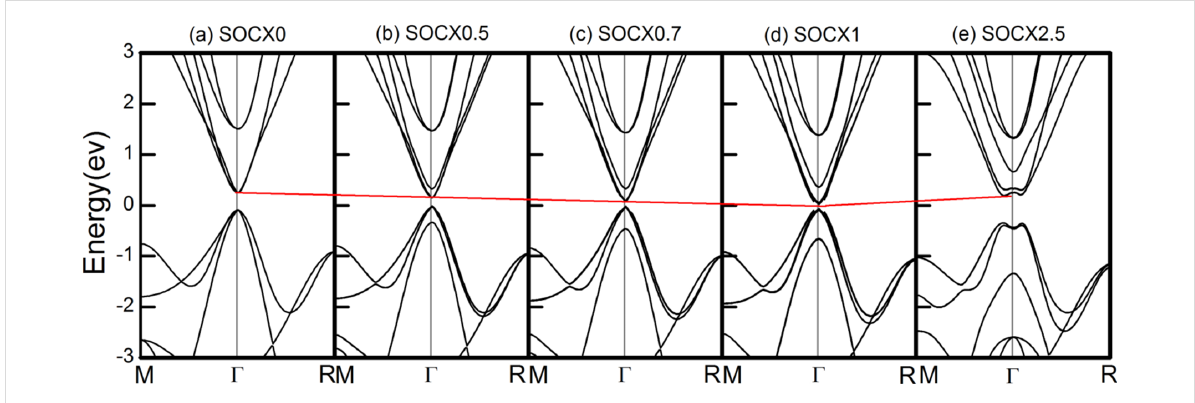
Figure 5: Band structures for 3D cubic ThTaN 3 with a 5% compressive strain as calculated by the HSE+SOC method at different SOC strengths (0–2.5 times). The Fermi energy level is set to zero.